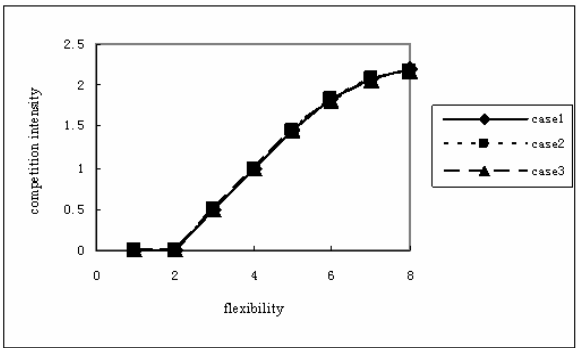
Fig. 6. Relationship between flexibility in the network and competition